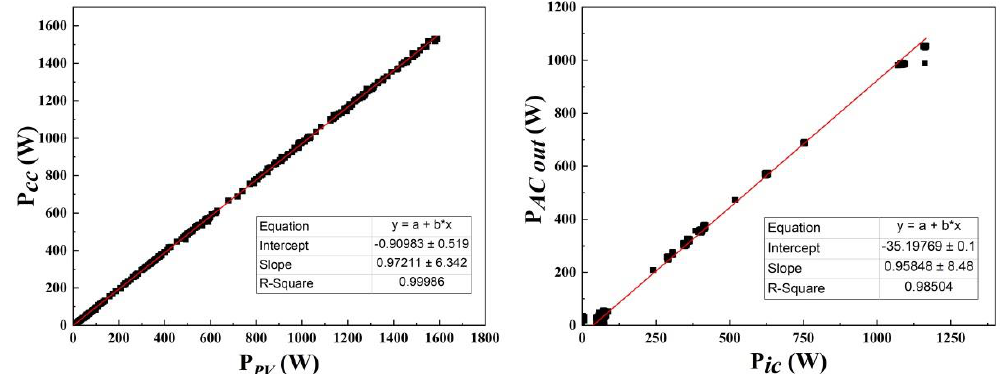
Figure 4. PV charge controller (left) and inverter (right) efficiency ratios.